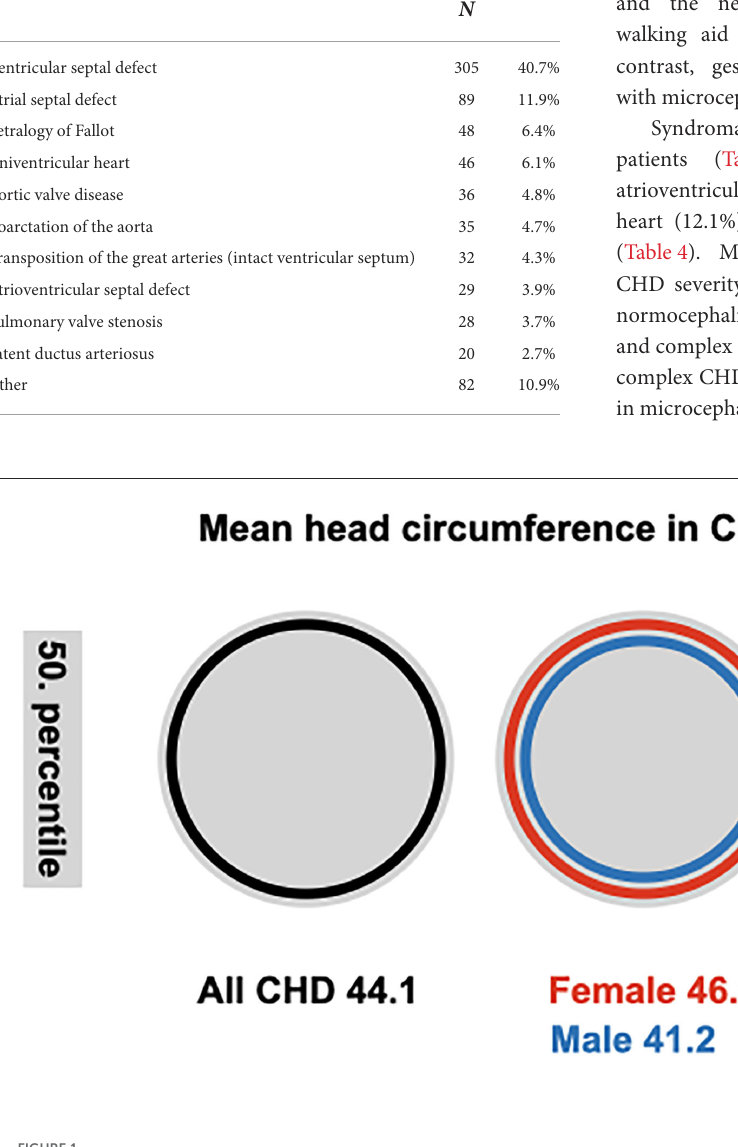
TABLE 2 CHD diagnoses of the patients in our cohort.